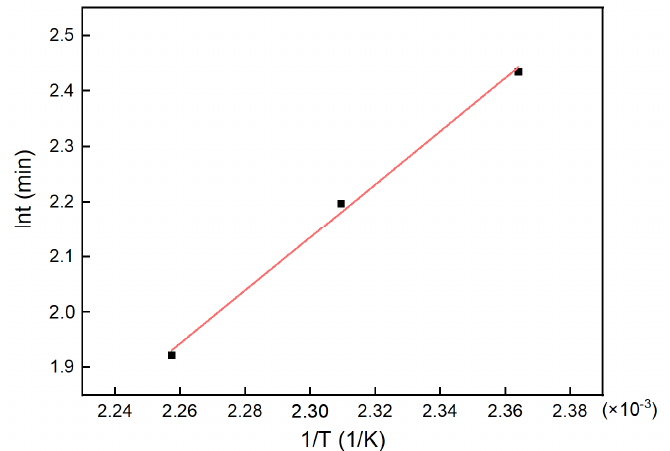
Figure 12. The fitting line for the gelation time of the H 6 XDI/BES system.